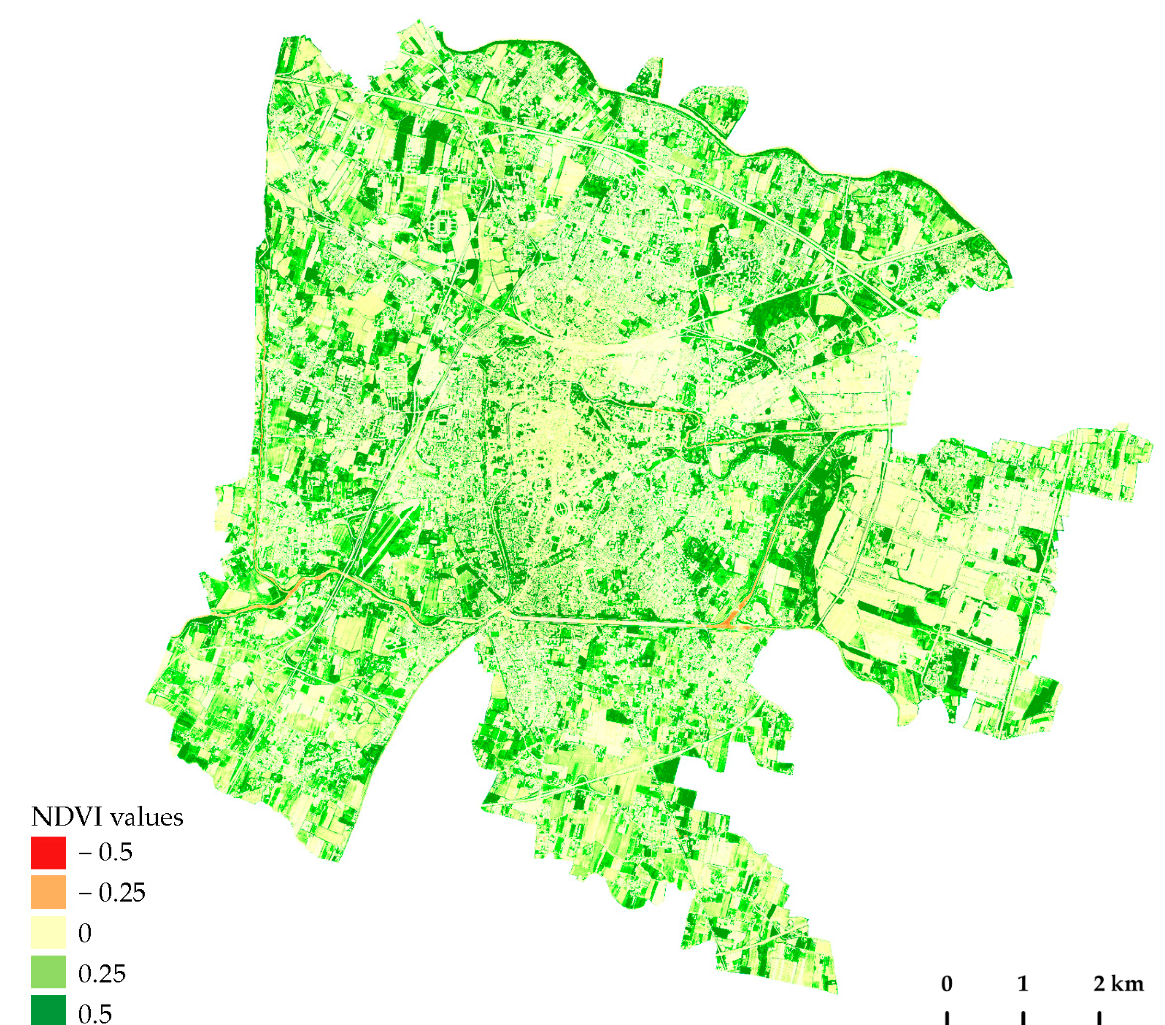
Figure 4. Urban green spaces in Padua by NDVI extraction, before integration with municipal topographic database.